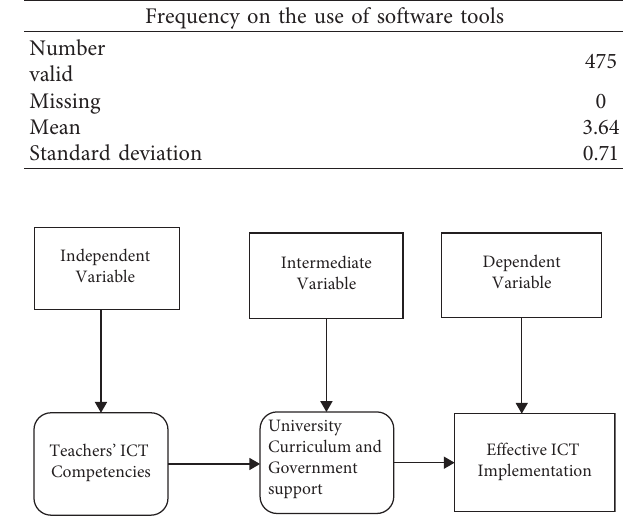
Figure 2: Researcher’s construct (2022).